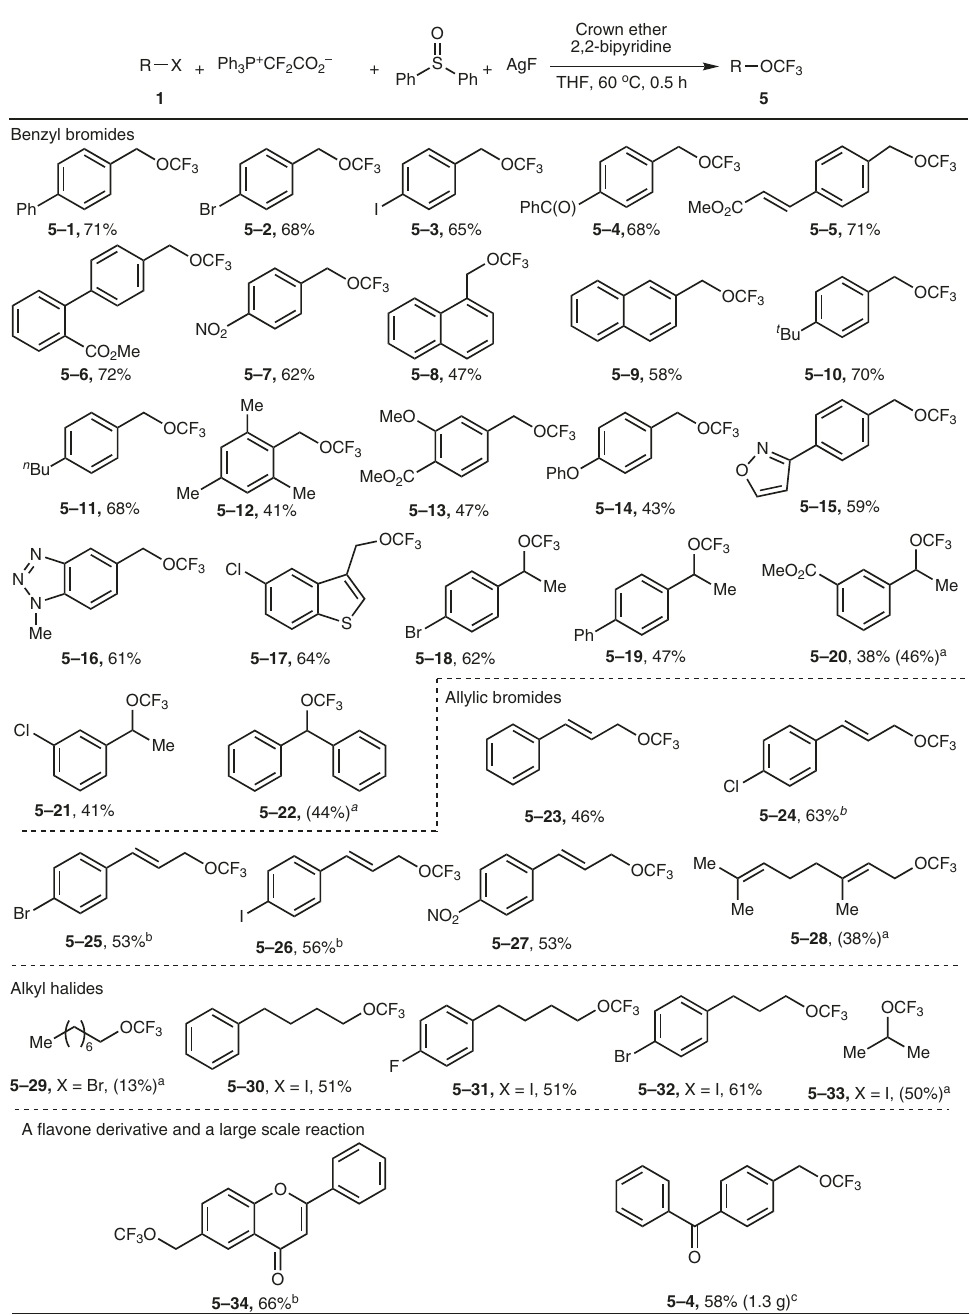
Fig. 4 Di fl uorocarbene-oxidation-based tri fl uoromethoxylation. Isolated yields are shown. Reaction conditions: substrate 1 (0.8 mmol), Ph 3 P + CF 2 CO 2 − (2.5 equiv), Ph 2 S = O (2.5 equiv), AgF (2 equiv), 2,2 ′ -bipyridine (1.5 equiv), and 2,3,11,12-dibenzo-18-crown-6 (0.5 equiv) in THF (6 mL) at 60 °C for 0.5 h. a The yields in parentheses were determined by 19 F NMR spectroscopy. b 0.2 mmol of substrate was used. c 8 mmol of substrate was used.